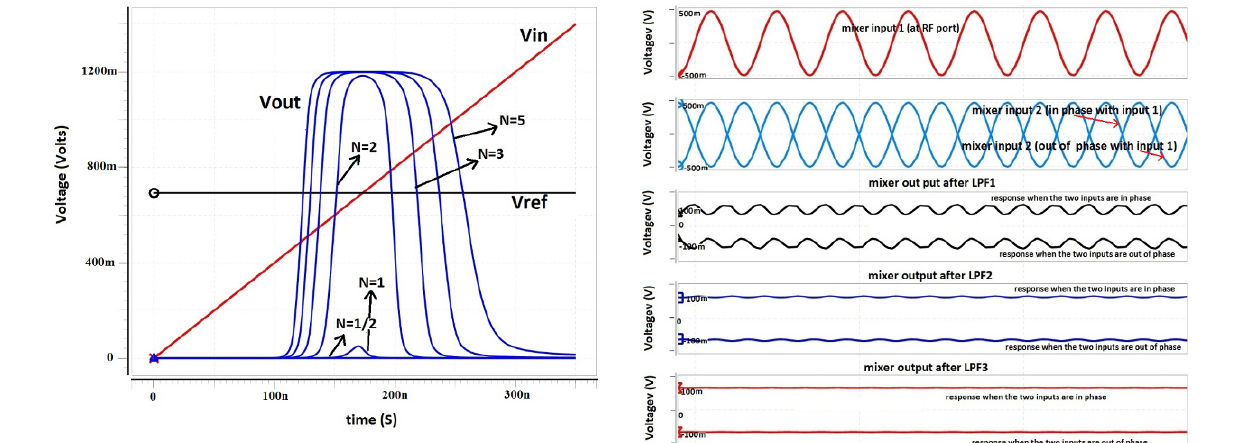
Figure 6. Influence of variable multiplication factor ( N ).